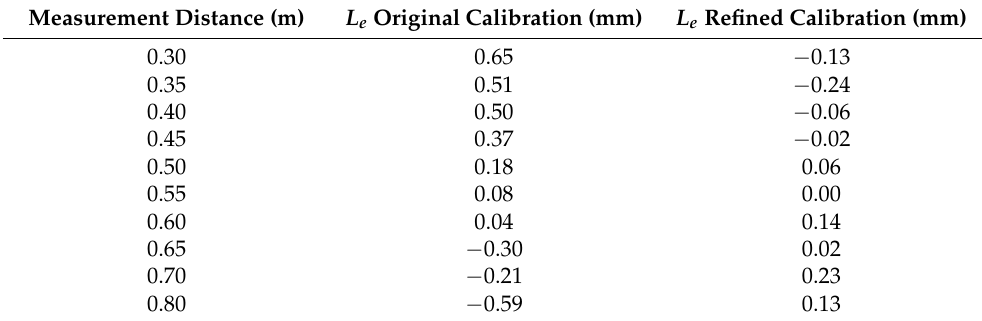
Table 2. Length-measurement error L e , depending on measurement distances before and after calibration refinement. The reference length of the ball bar is 199.926 mm with 1.8 µ m of uncertainty, according to the calibration certificate.